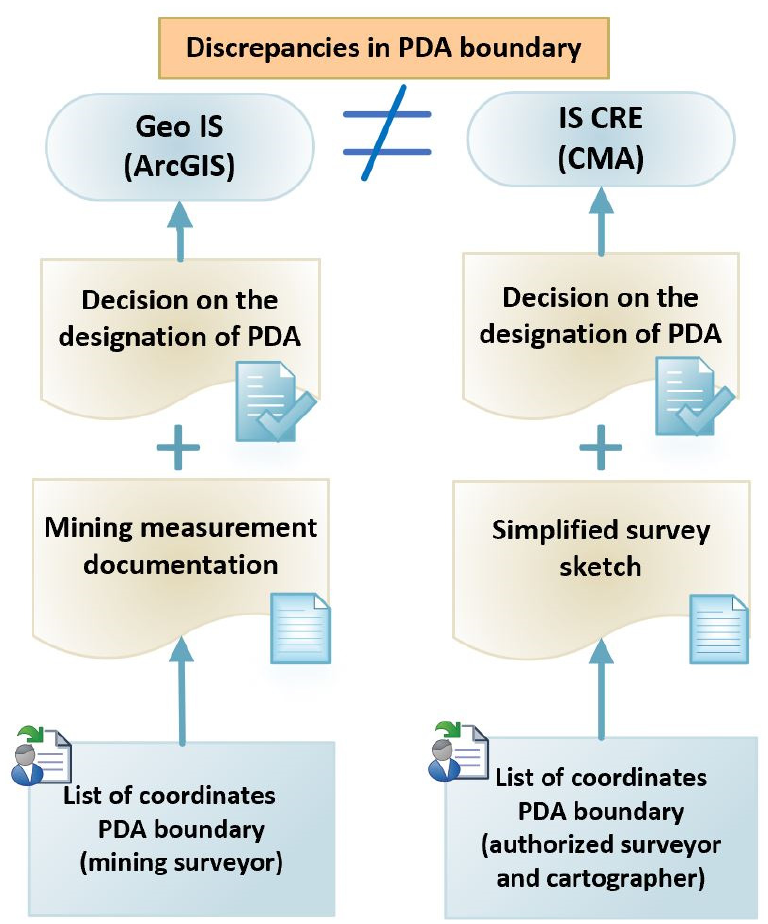
Figure 7. Illustration of the way to submit PDA data for updating.